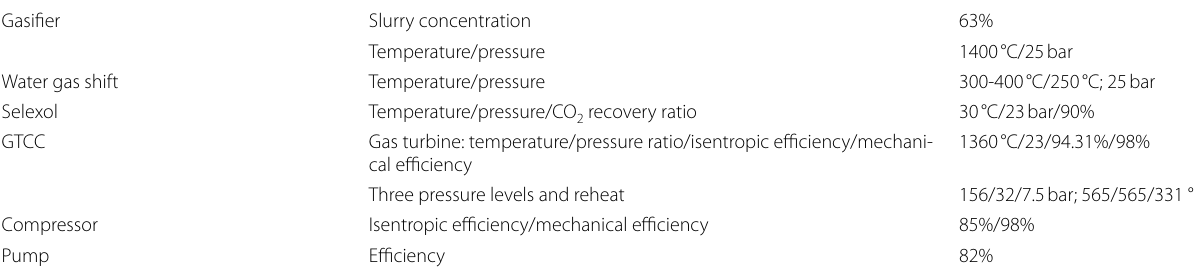
Table 3 Parameters for primary unit simulation